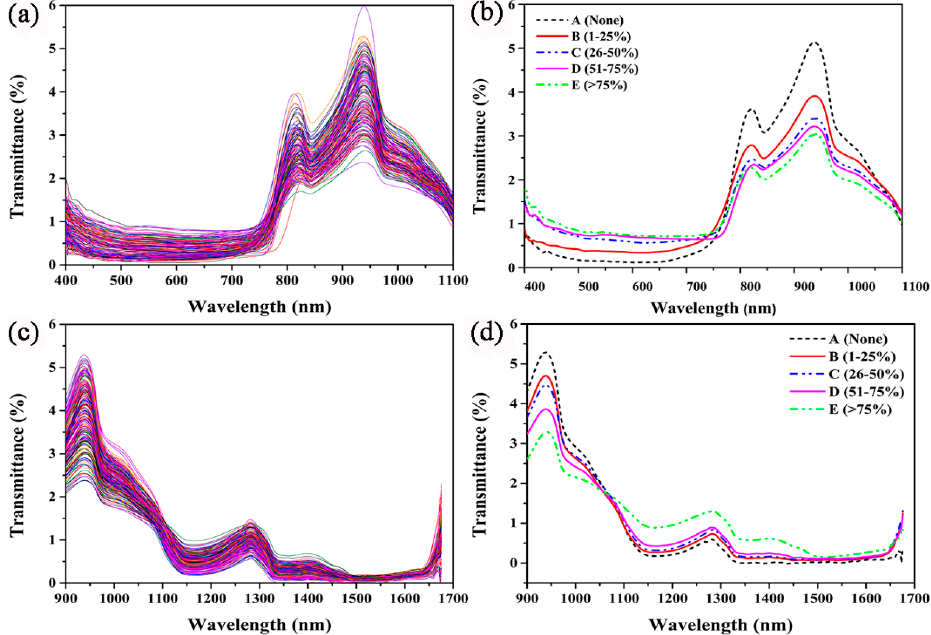
Figure 7. Visible and near-infrared transmittance spectra of samples: ( a ) and ( c ) raw spectra; ( b ) and ( d ) mean spectra for different granulation levels.